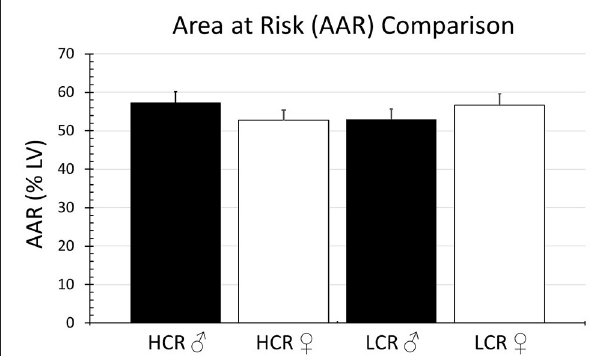
myocardium rendered ischemic by coronary occlusion was comparable in all groups.